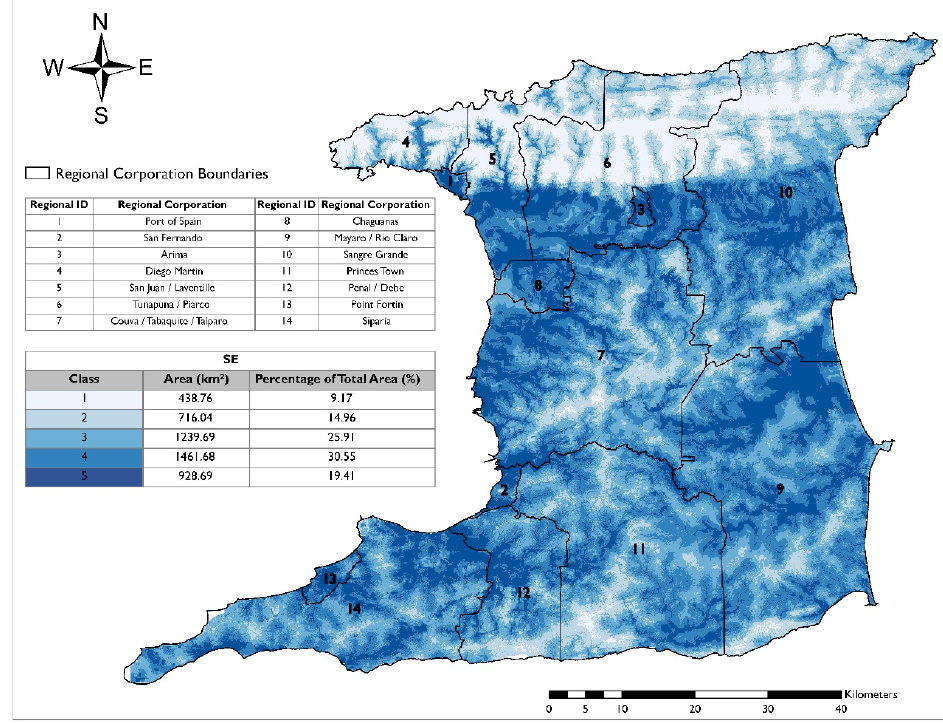
Figure 9. Flood Hazard Indexes created for SE.